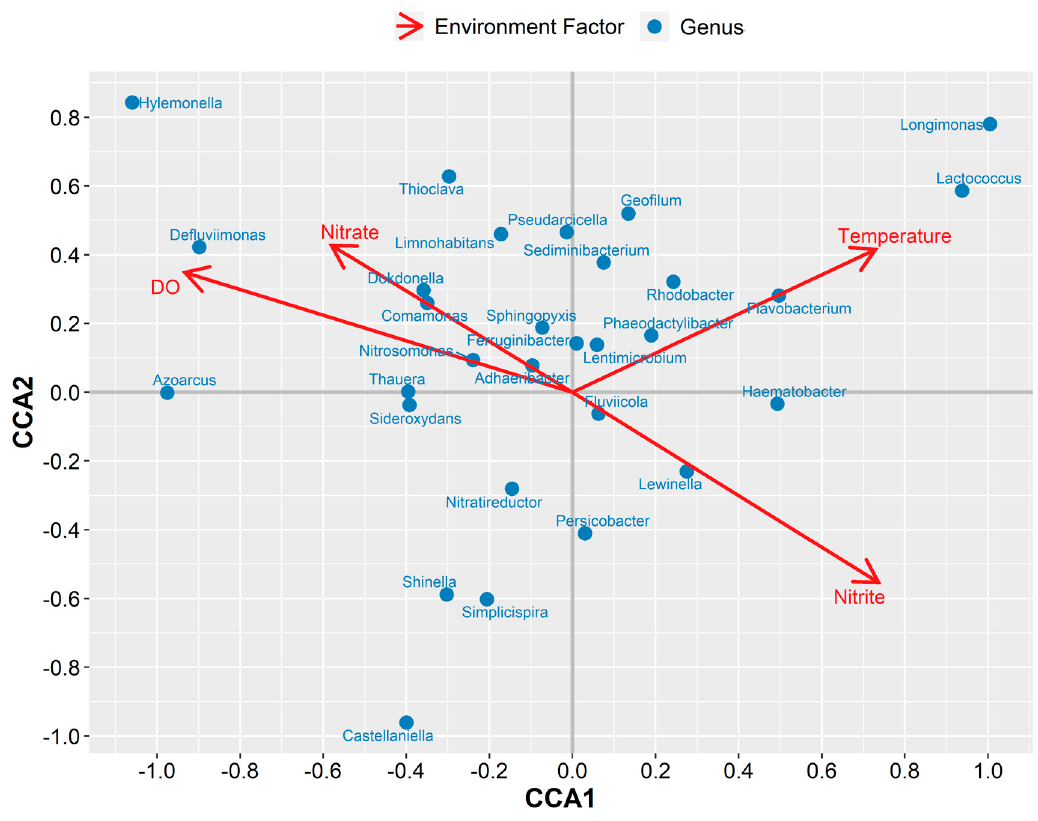
Figure 4. Canonical correspondence analysis (CCA) of the microbial community with respect to the operating conditions. CCA1 and CCA2 represent the first two ordination axes. The blue dots represent the top thirty genera in abundance, and the red arrows represent environment factors in the systems.